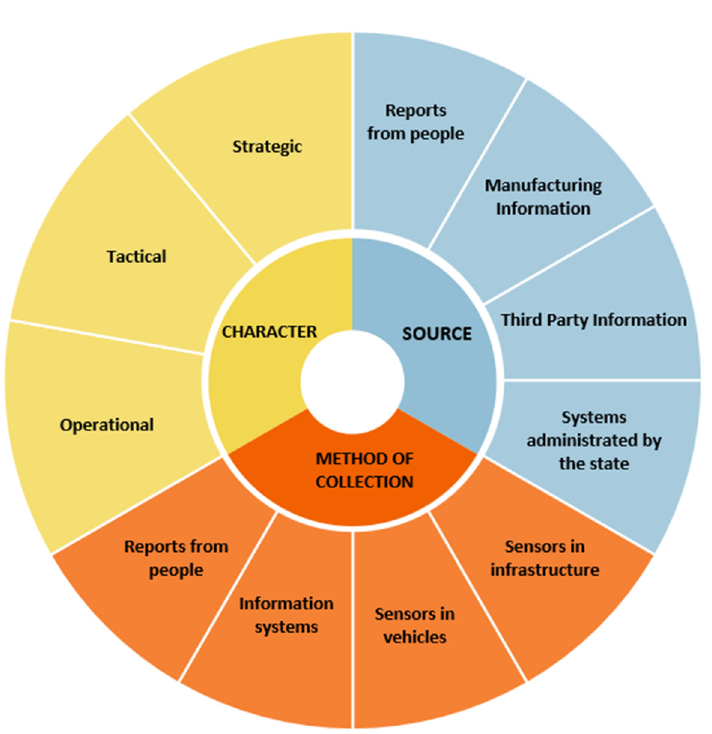
Figure 6. Categorization of data collected within V2I.